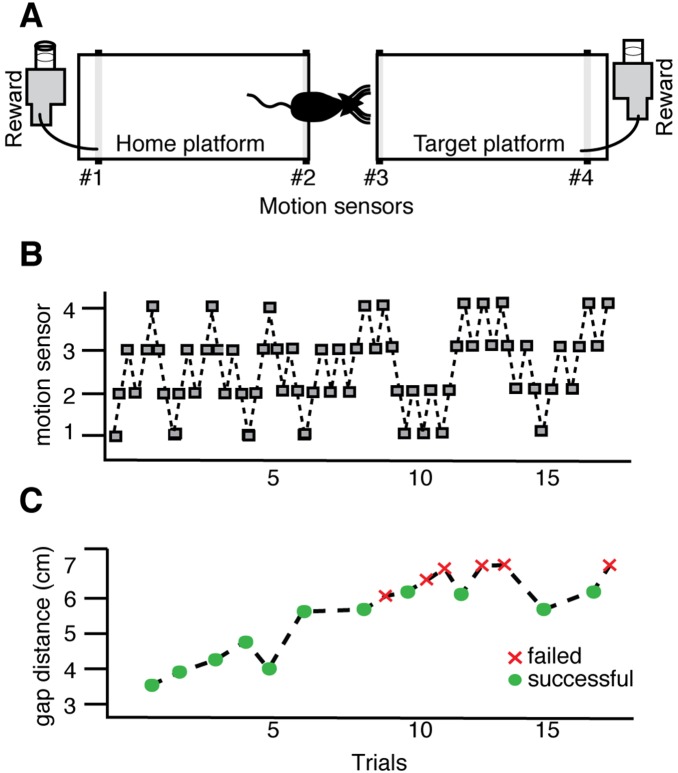
The Gap Cross task is a whisker-dependent sensory learning paradigm.(A) Schematic of the gap cross learning task. Motion sensors positioned at four points along the 2 platforms (labeled #1–4) track the mouse as it moves from the starting platform across a given gap distance to the target platform. (B) Activation of each sensor (grey box) indicates the position of the mouse. (C) Successful crosses are defined as the movement of the mouse from the starting platform to the target platform (green circles). Failures are defined as trials in which the mouse approaches the edge of the home or target platform and returns to the back of the home platform (red crosses).